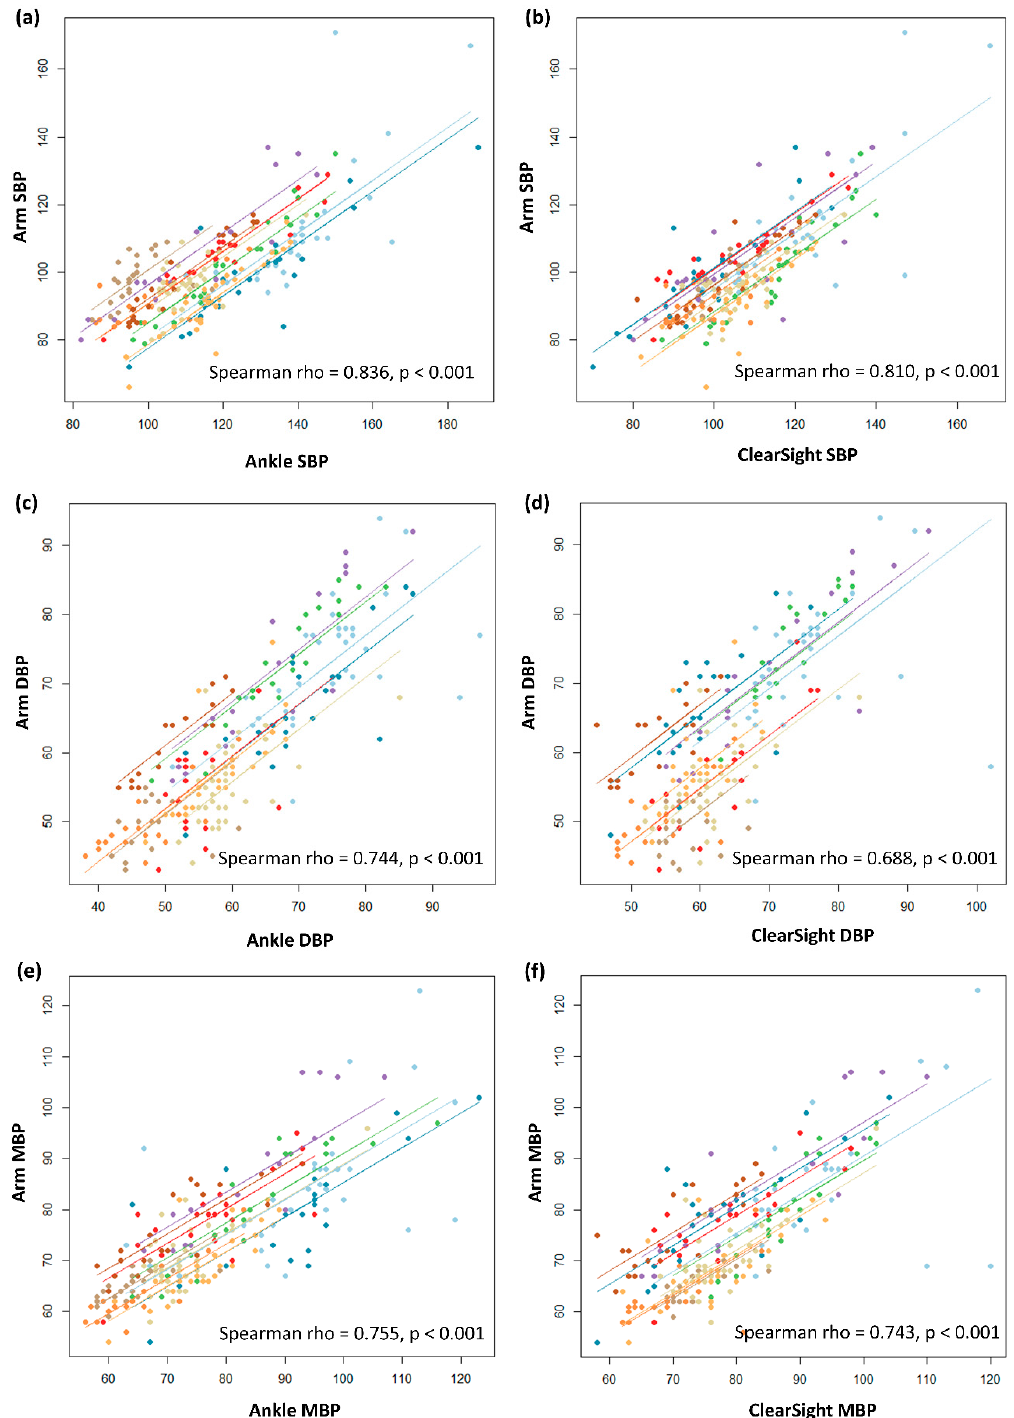
Figure 2. The scatterplots for correlation of blood pressure measurements. ( a ) Correlation between systolic blood pressure (SBP) of arm and ankle. ( b ) Correlation between SBP of arm and ClearSight. ( c ) Correlation between diastolic blood pressure (DBP) of arm and ankle. ( d ) Correlation between DBP of arm and ClearSight. ( e ) Correlation between mean blood pressure (MBP) of arm and ankle. ( f ) Correlation between MBP of arm and ClearSight. Each color of the dots and the regression lines represents each patient.